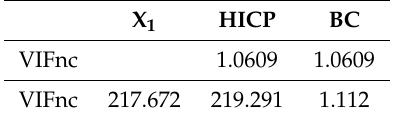
Table 11. VIFnc of auxiliary regressions associated to model